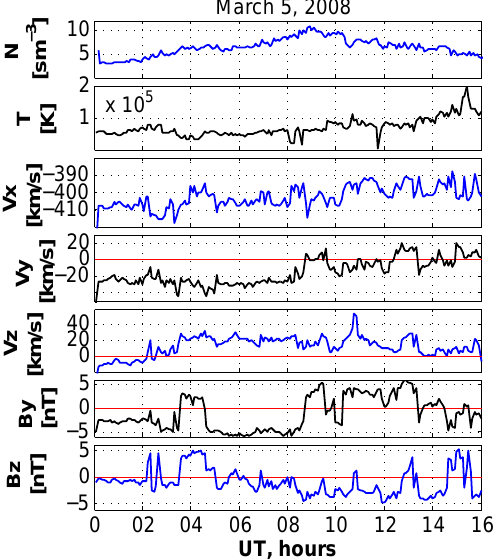
Figure 4. The input parameters of the simulation BAT- SRUS_Sergeev_060508_1. From top to bottom: ion density ( N ), ion temperature ( T ), solar wind speed components ( V x ,V y ,V z ) and IMF components ( B x ,B y ,B z ).